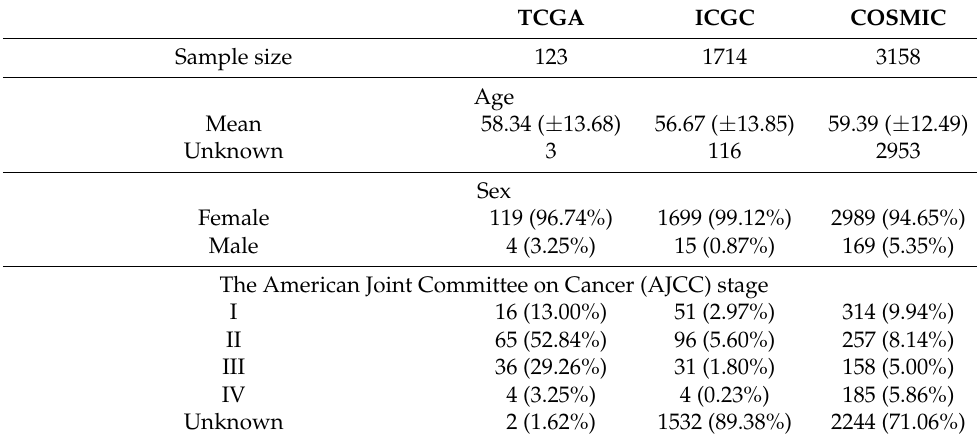
Table 2. Characteristics of BRCA1 -negative